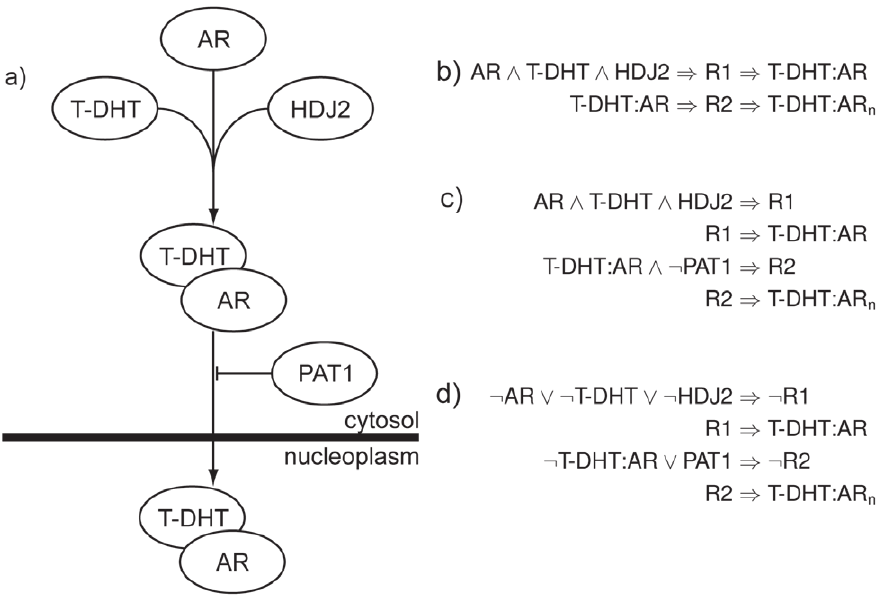
Figure 1. An example of a PATHLOGIC-S formulation. a) A pair of reactions from the androgen receptor pathway of the NCI-Nature Pathway Interaction Database [6,35–38]. Inhibiting interactions are presented with a flat-ended arrow. b) Initial logical formulation. Conversion of upstream signals, catalysts, and activating signals takes place at this point. c) Logical statements with inhibition information added, prior to conversion to disjunctive form. d) Logical statements in disjunctive form prior to conversion to a system of linear constraints.